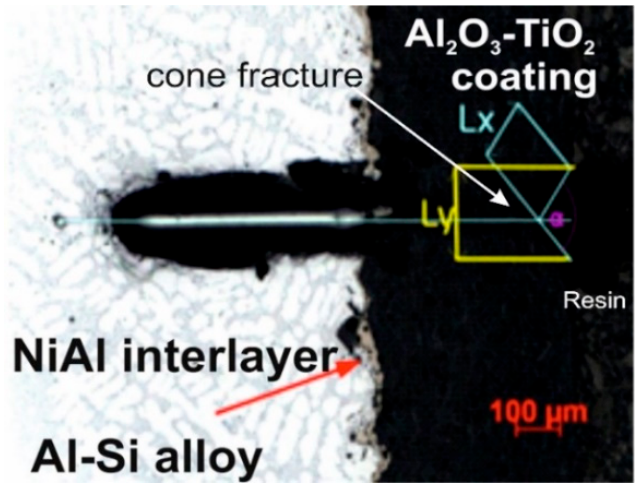
Figure 2. Schematic of constant load scratch on the cross sectioned sample.